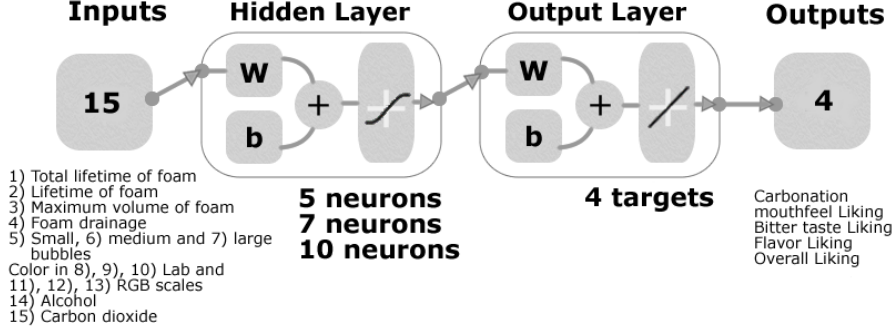
Figure 2. A two-layer feedforward model diagram showing the 15 inputs, number of neurons tested in the hidden layer, and targets/outputs used to create the